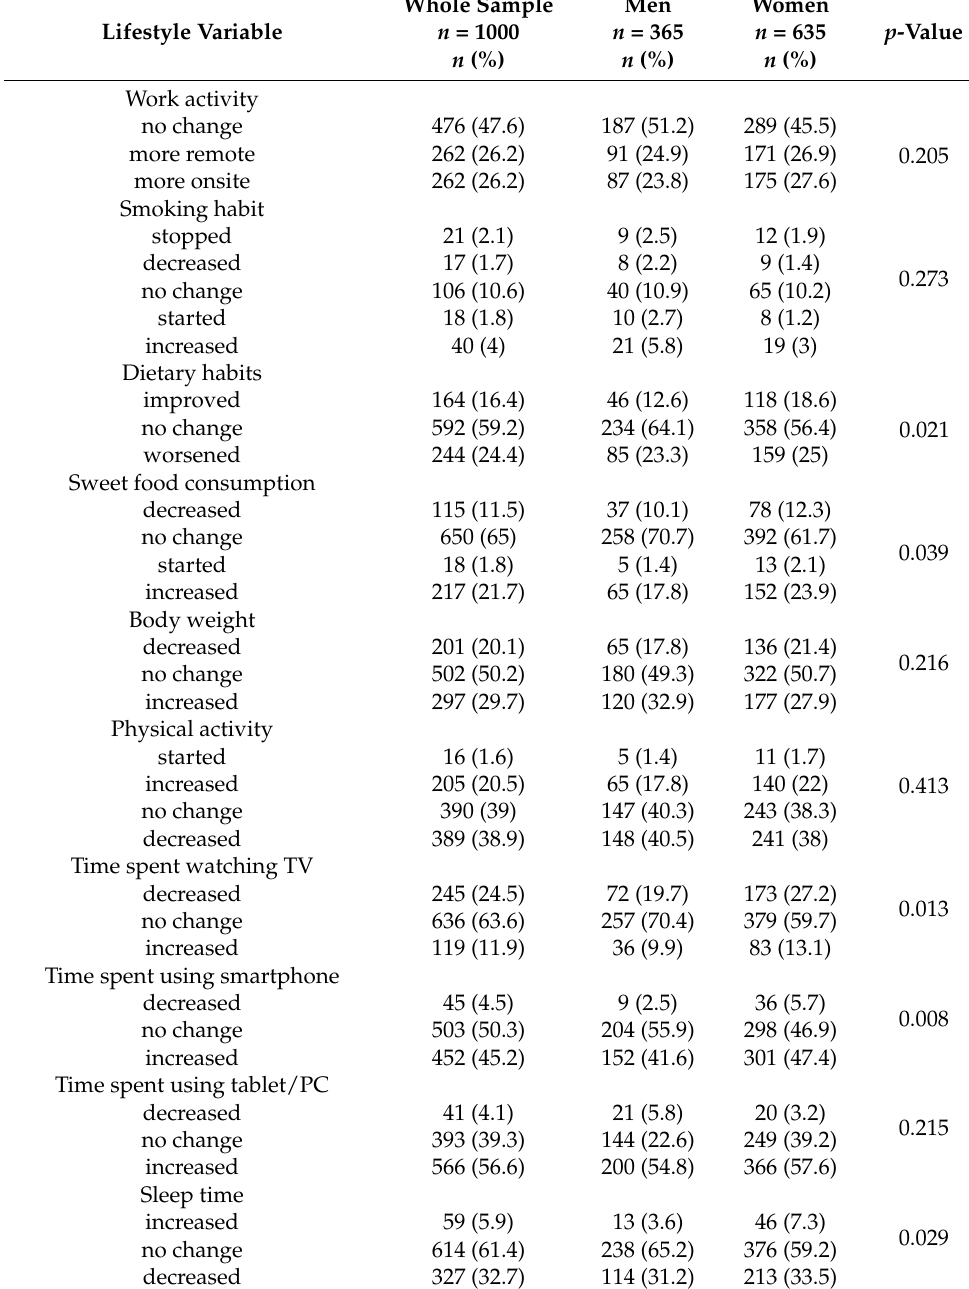
Table 3. Lifestyle changes during the pandemic for the total sample and grouped by gender.